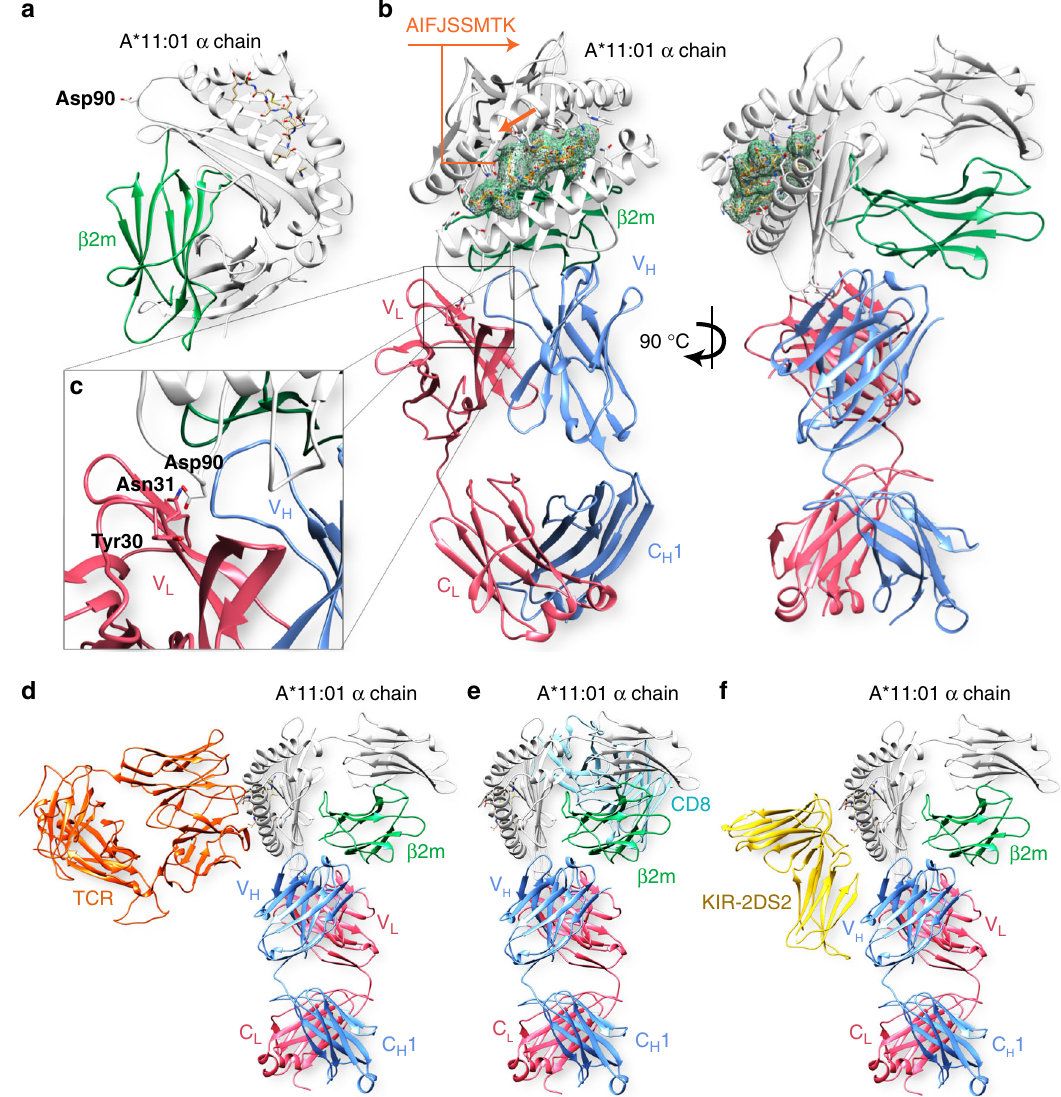
Fig. 2 Key features of the binding interface between 2E3-Fab and HLA-A*11:01. a Aspartic acid at position 90 (Asp90) is the predicted eplet for 2E3 and is highlighted on the structure of A*11:01 (PDB 2HN7). b The structure of 2E3-Fab complexed with HLA-A*11:01 monomer was solved by X-ray crystallography at 2.4 Å. Fab fragment of 2E3 consists of heavy chain (blue ribbon) and light chain shown (pink ribbon). It interacts with refolded HLA- A*11:01 which comprises of α chain shown in white, β 2m shown in green and a peptide shown as mesh. c Magni fi ed view of the interaction between 2E3- Fab and HLA-A*11:01 near the predicted eplet (Asp90). The Asn31 of 2E3 light chain variable region interacts with Asp90 of HLA α chain. d View of interaction interface between 2E3-Fab and HLA-A*11:01, when KIR2DS2 (PDB 4N8V), e TCR (PDB 5WKH), and f CD8 (PDB 1AKJ) are bound to the same HLA molecule. HLA human leukocyte concentration of 2 μ g mL − 1 . 2E3-IgG4 antibody only induced signi fi cant CDC at a high concentration of 20 μ g mL − 1 with less